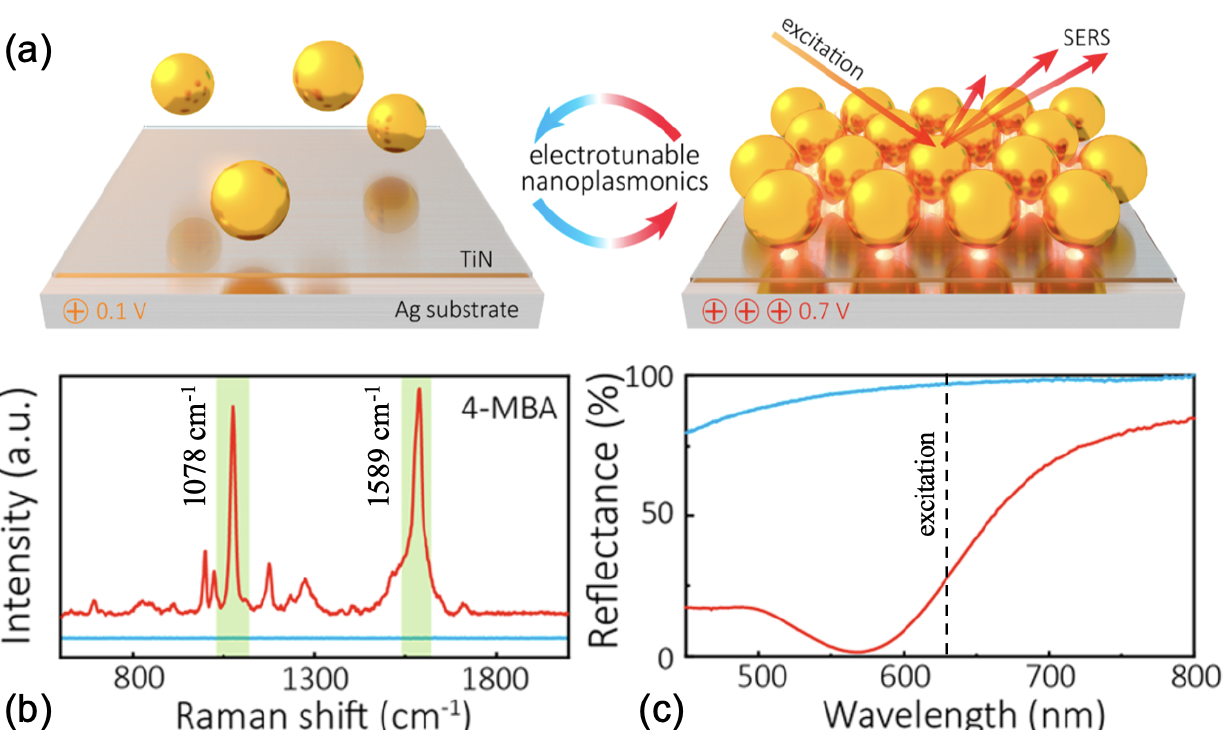
Figure 2. ( a ) Illustration of the electrotunable plasmonic metasurface composed of gold nanoparticles assembled on TiN/Ag substrate at 0.1 V vs. PZC (at left) and 0.7 V vs. PZC (at right). ( b ) SERS spectra of 4-MBA adsorbed on the metasurface at 0.1 V vs. PZC (blue color) and 0.7 V vs. PZC (red color). ( c ) Reflectance spectra of the plasmonic metasurface at 0.1 V vs. PZC (blue color) and 0.7 V vs. PZC (red color). The dashed black line corresponds to the excitation wavelength used for SERS measurements. All the figures are reprinted (adapted) with permission from [69], Copyright 2020 American Chemical